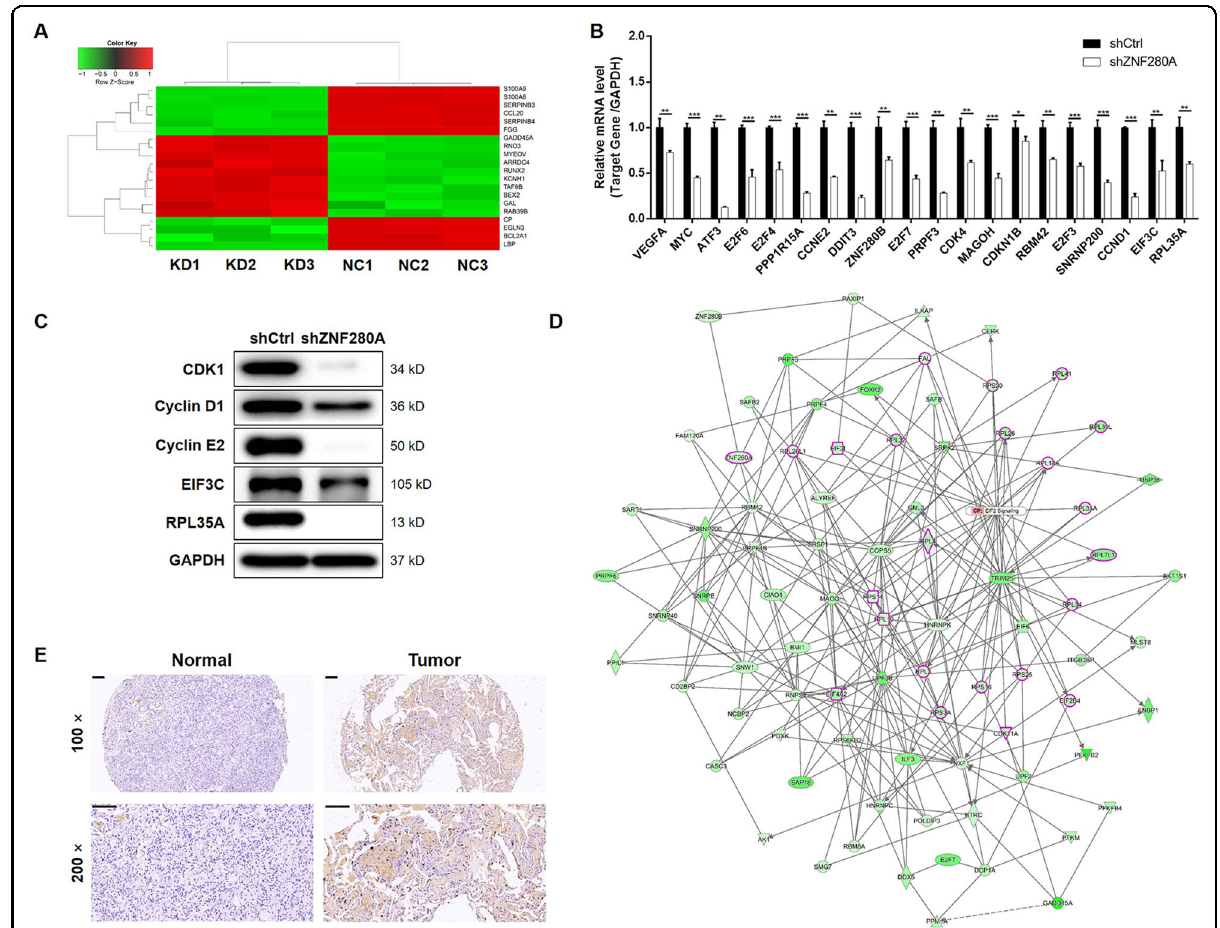
Fig. 4 The exploration and veri fi cation of downstream underlying ZNF280A-induced regulation of LUAD. A A PrimeView Human Gene Expression Array was performed to identify the differentially expressed genes (DEGs) between shZNF280A and shCtrl groups of NCI-H1299 cells. B , C qPCR B and western blotting C were used to detect the expression of several selected DEGs in NCI-H1299 cells with or without ZNF280A. D A ZNF280A associated interaction network constructed by IPA analysis revealed the potential linkage between ZNF280A and EIF3C. E The expression of EIF3C in LUAD tissues and normal tissues was evaluated by IHC analysis (Scale bar = 100 μ m). Data were shown as mean ± SD. * P < 0.05, ** P < 0.01, *** P <